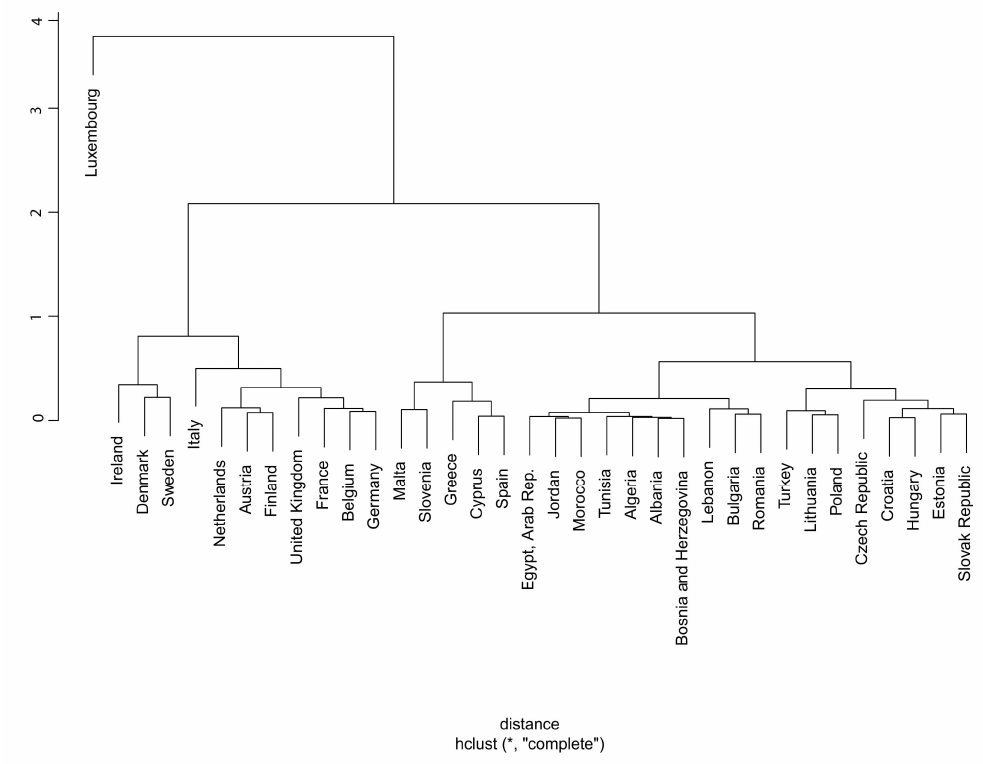
Figure 1. Hierarchical Cluster Analysis ( HCA) dendrogram analysis.